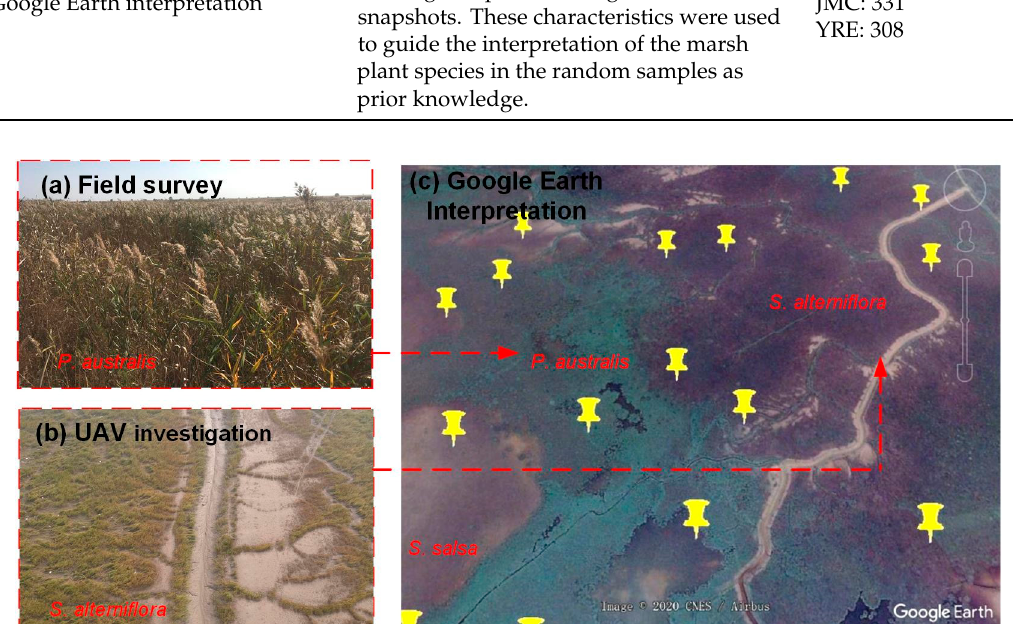
Figure 3. Sample collection methods employed in salt marsh ecosystems, including ( a ) field survey, ( b ) UAV investigation, and ( c ) Google Earth imagery. Note: red arrows point to photograph locations obtained using both a handheld camera and UAV survey, and the yellow pins represent samples randomly generated in ArcGIS.